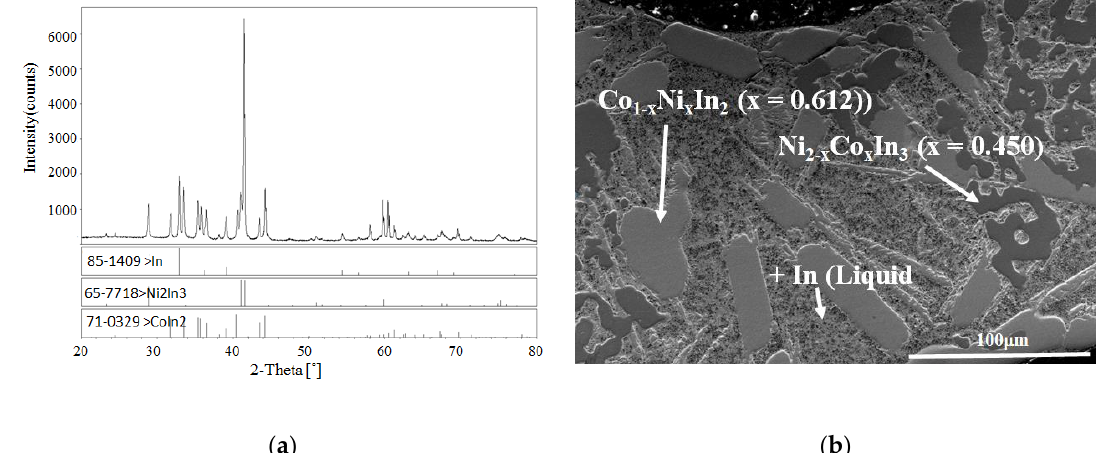
Figure 6. ( a ) XRD pattern and ( b ) BSE micrograph of No. 32 (Co8Ni22In70).